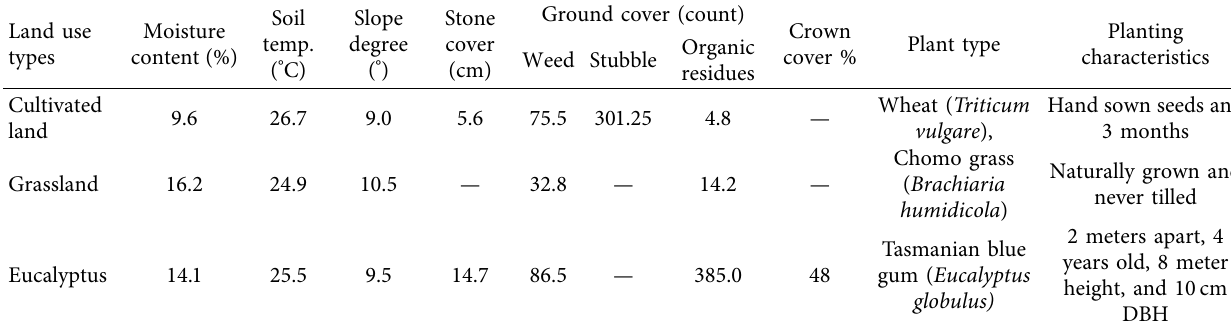
Table 1: Mean of biophysical conditions of the sampling